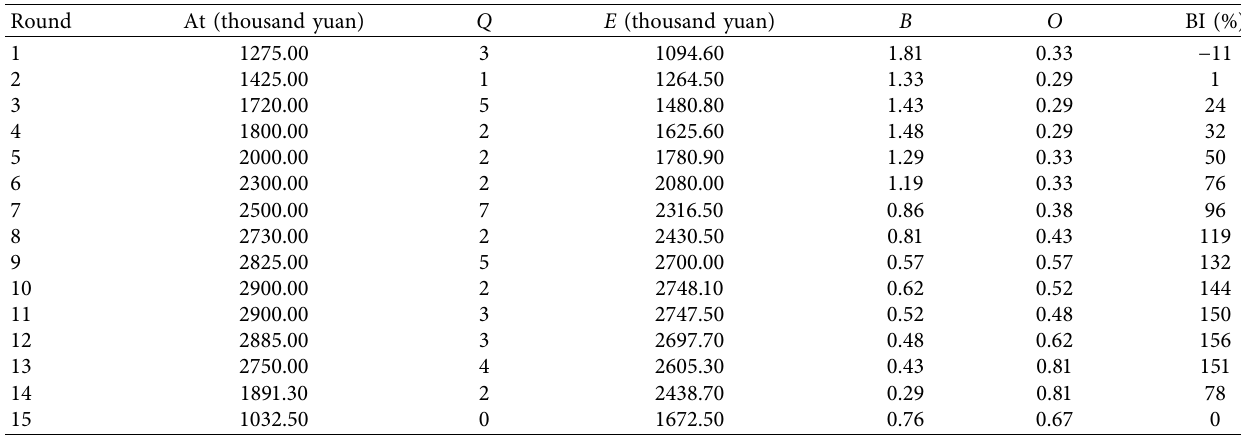
Table 7: Statistical indicators of low lending rate group.